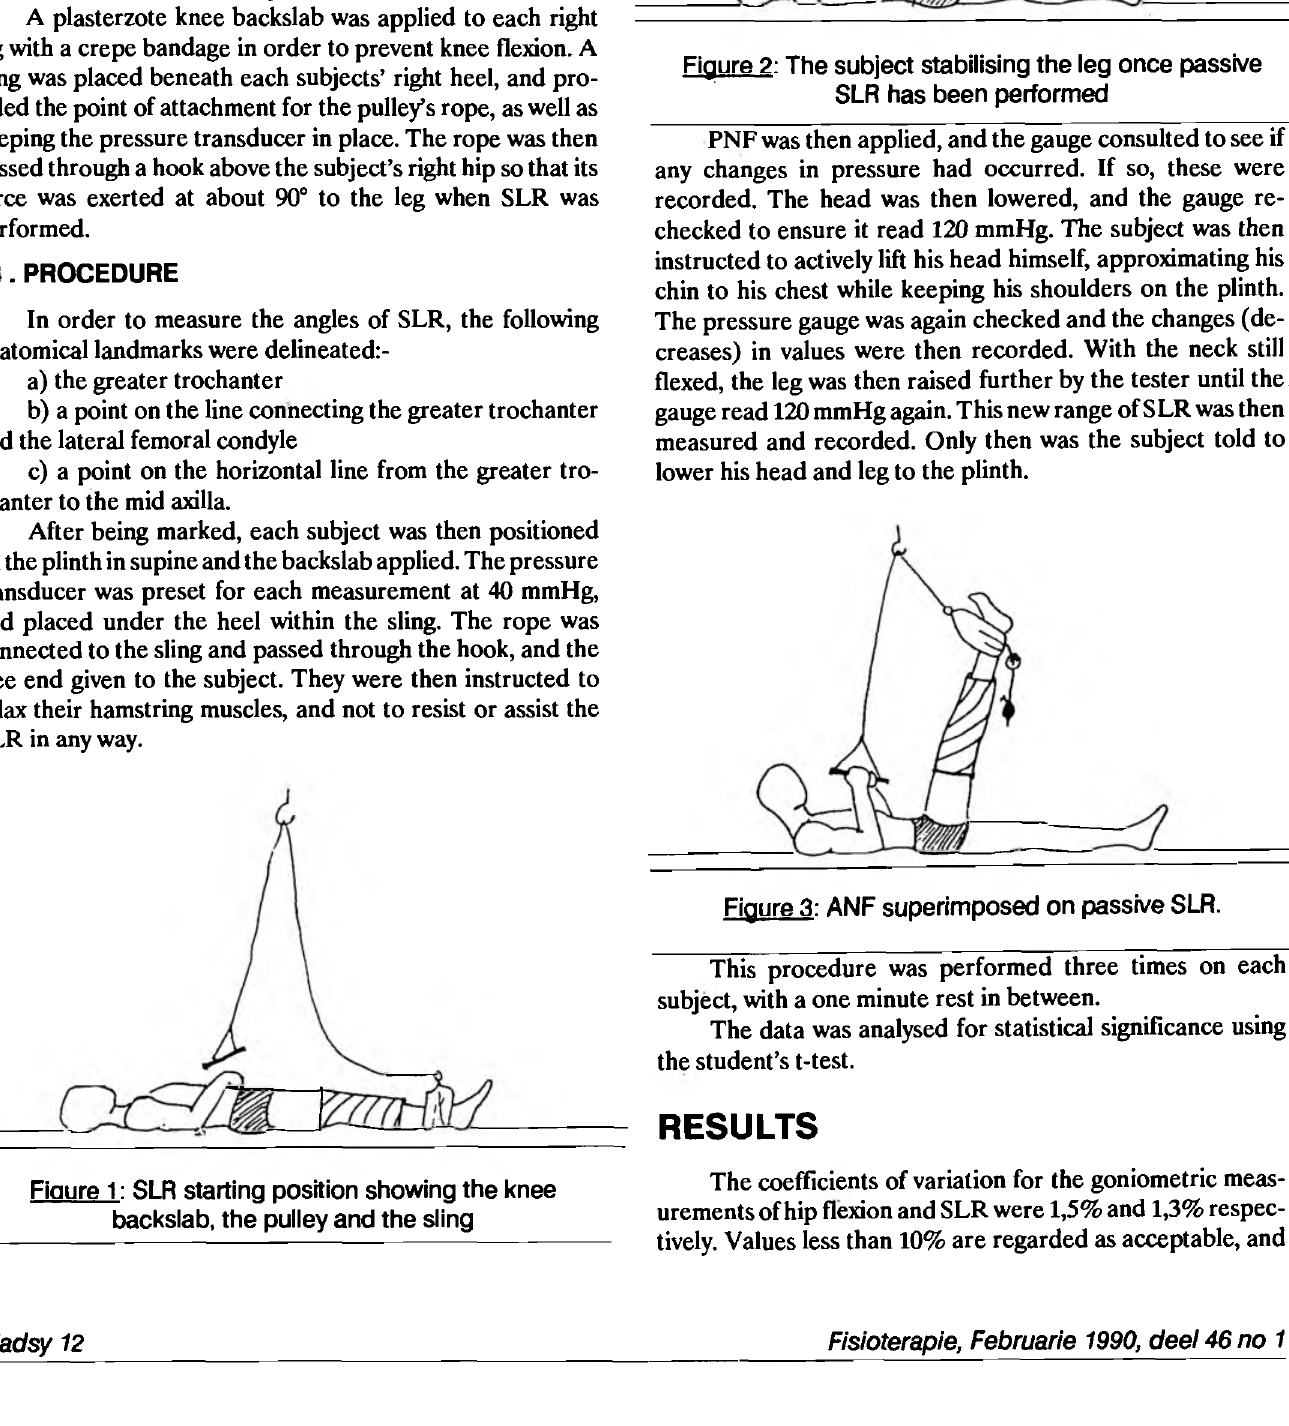
Figure 1: SLR starting position showing the knee backslab, the pulley and the sling